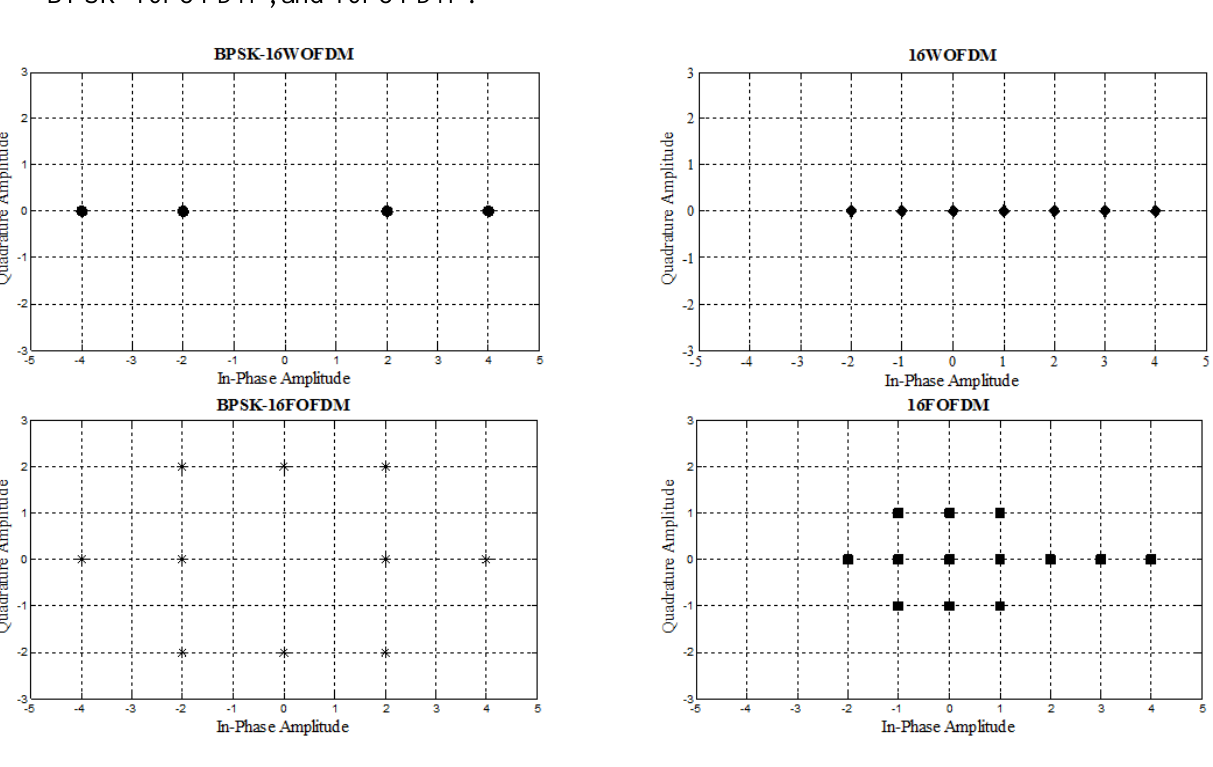
Figure 3. Real and imaginary components of BPSK-16WOFDM, 16WOFDM, BPSK-16FOFDM, and